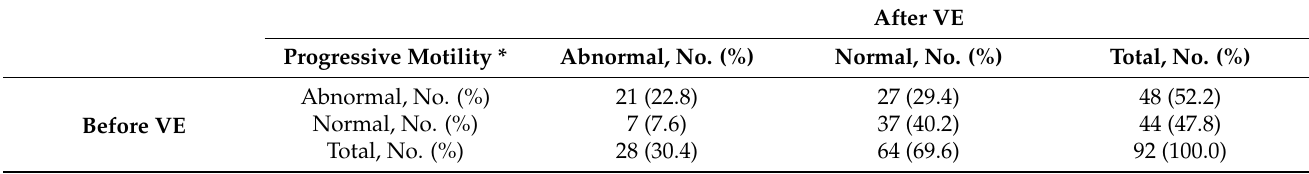
Table 5. Cross-tabulation table showing the number of patients with abnormal and normal progressive sperm motility at 1 h (H1) in the first semen analysis before varicocele embolization (VE) versus in the second semen analysis after VE. After VE Progressive Motility * Abnormal, No. (%) Normal, No. (%) Total, No. (%)